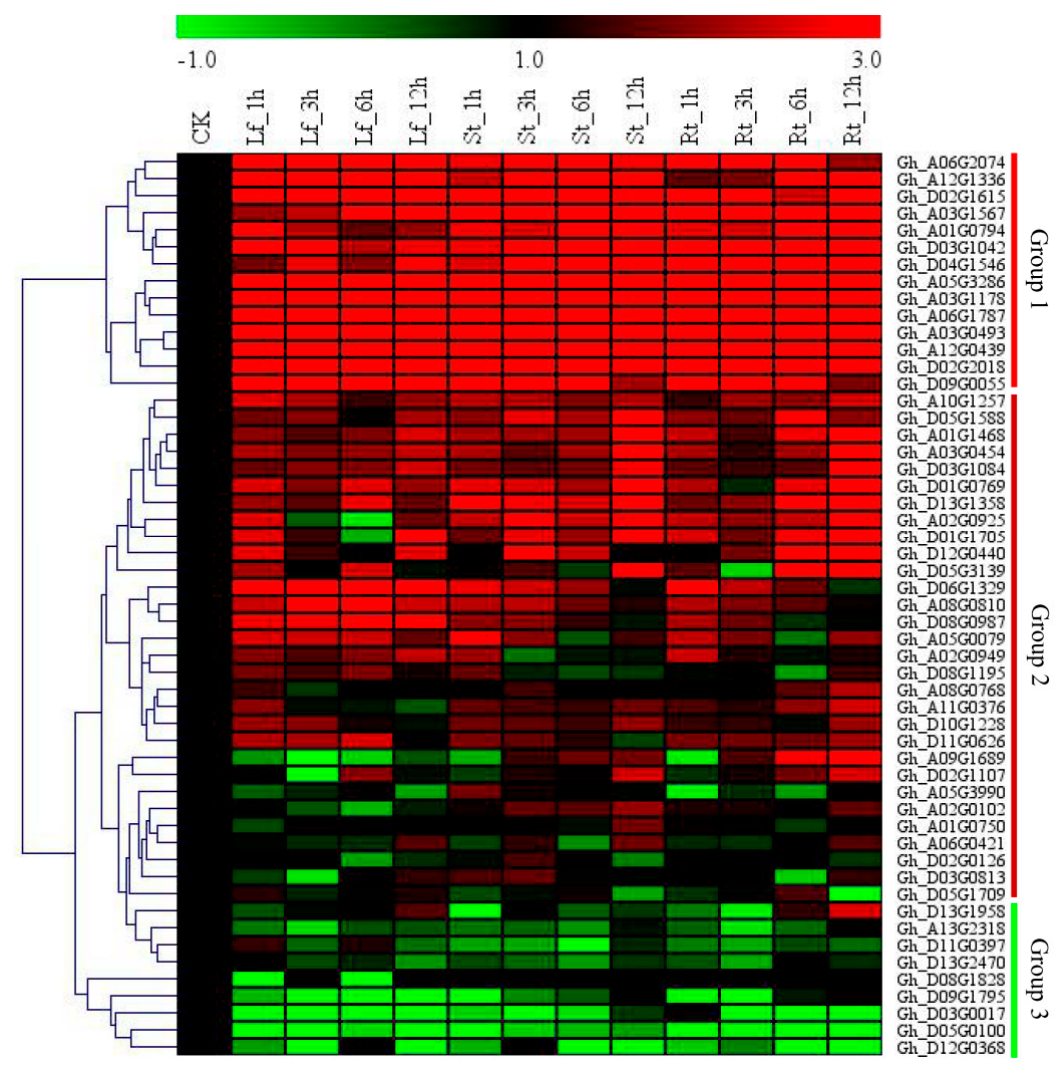
Figure 4. Expression Analysis of the selected GhNLP genes. Cotton seedlings were grown in a hydroponic setup with a modified Hoagland nutrient solution, N-limited condition imposed by adjusting the N-content to 0.05 mM NO 3 − concentration, and normal N-condition maintained at 7.5 mM NO 3 − concentration. The leaf, stem and root tissues were harvested at 0 h, 1 h, 3 h, 6 h, and 12 h. RNA extracted and the expression levels of the 53 selected GhNLP genes analysed by RT-qPCR with GhActin as the internal control. The heat map was visualized using Mev.exe program (Showed by log 2 values). Red: up-regulated, green: down-regulated and black-no significant difference in expression levels compared to control (ANOVA, p < 0.05).